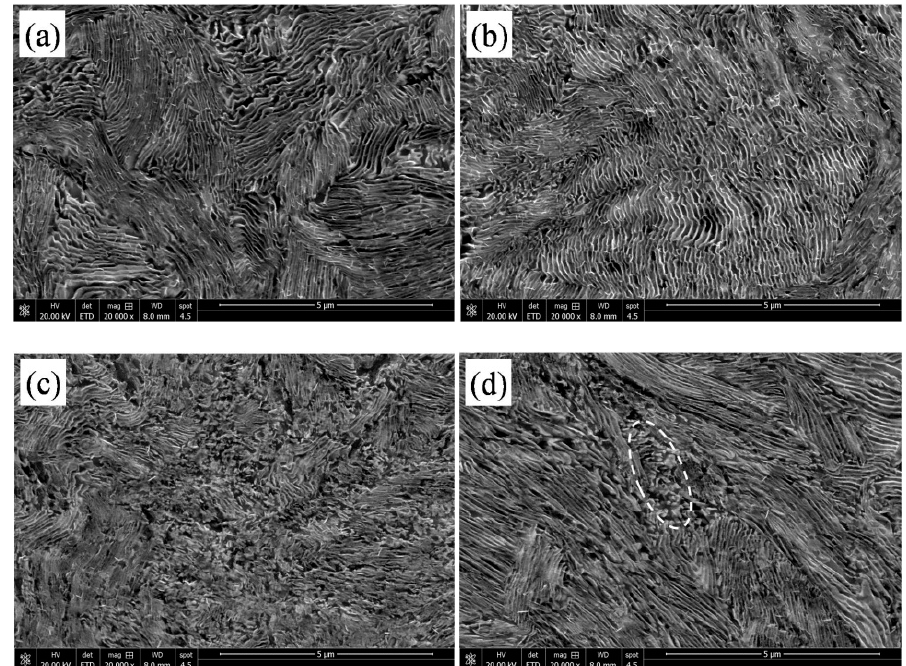
Figure 5. SEM micrographs acquired from the cross section of steel wires: ( a ) cold ‐ drawn wires, surface; ( b ) cold ‐ drawn wires, center; ( c ) cold ‐ drawn wires annealed at 450 °C for 5 min, surface; ( d ) cold ‐ drawn wires annealed at 450 °C for 5 min, center.